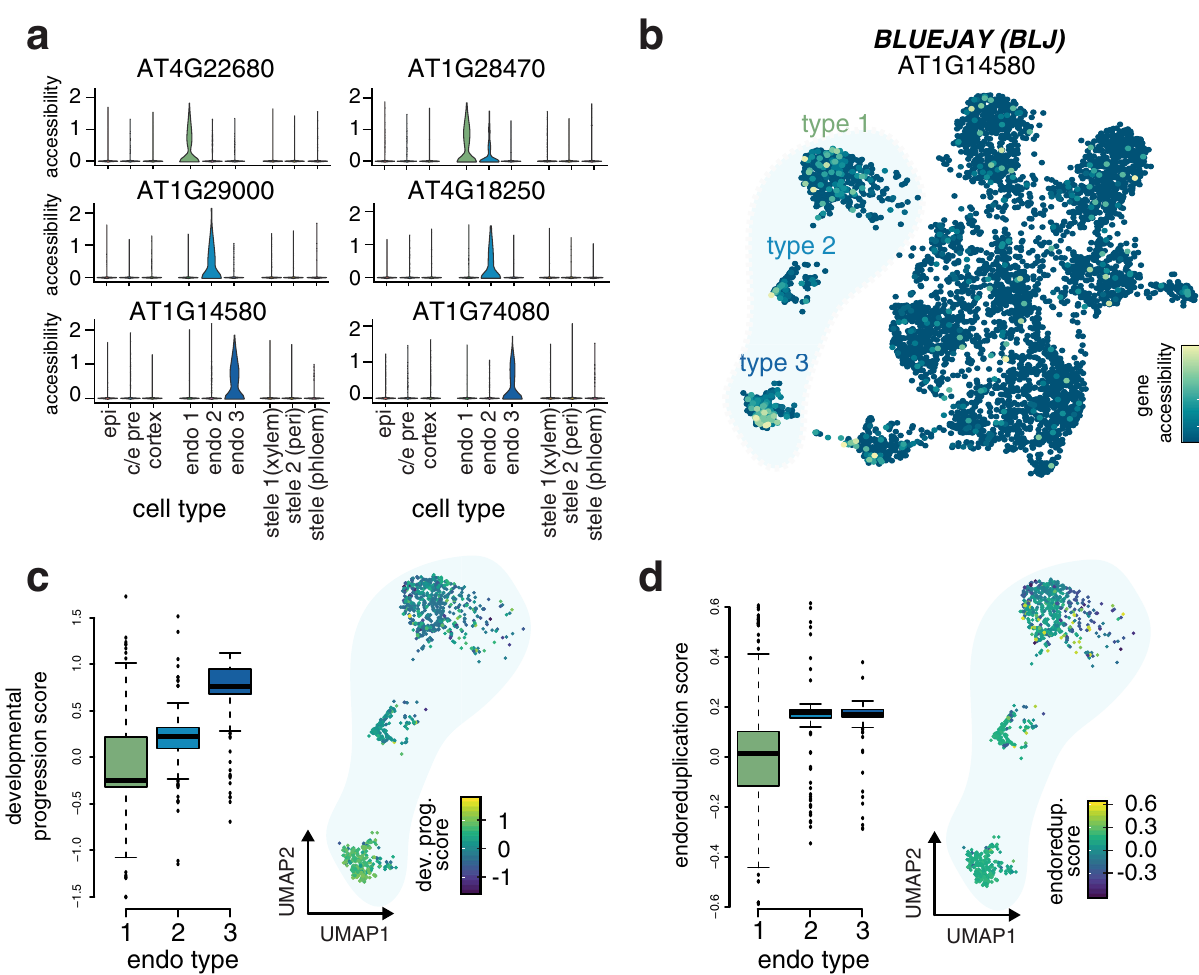
Fig. 3 scATAC-seq identi fi es distinct sub-types of endodermal cells. a Violin plots showing speci fi c patterns of accessible genes that mark each endodermal sub-type. Two examples are given for each endodermal sub-type, with gene-level accessibility scores indicated for all other cell types. b UMAP of all cells colored by accessibility of the BLUEJAY gene, which marks endodermal type 3; corresponding violin plot for this gene in lower left panel in a . c Boxplot showing an increase in median developmental progression of each endodermal sub-type, as determined by average transcriptional complexity in the nearest 25 scRNA neighbors of each scATAC cell in the co-embedded representation from Fig. 2a; right inset shows UMAP of endodermal cells with each cell colored by the average developmental progression of its scRNA neighbors, mirroring the gradual increase seen in left panel. Boxplots are generated using values from individual endodermis cells (early n = 489 cells, mid n = 141 cells, late n = 225 cells); whiskers represent 1.5 times the interquartile range of the data, the box represents the interquartile range, and the horizontal line in the box represents the median. d Boxplot showing an increase in median levels of endoreduplication across endodermal sub-types, ascertained as in c , but instead using a gene expression signature of endoreduplication; right inset shows UMAP of endodermal cells with each cell colored by the average endoreduplication score of its scRNA neighbors, with highest levels seen in endodermal sub-types 2 and 3 (number of cells, n , identical to previous